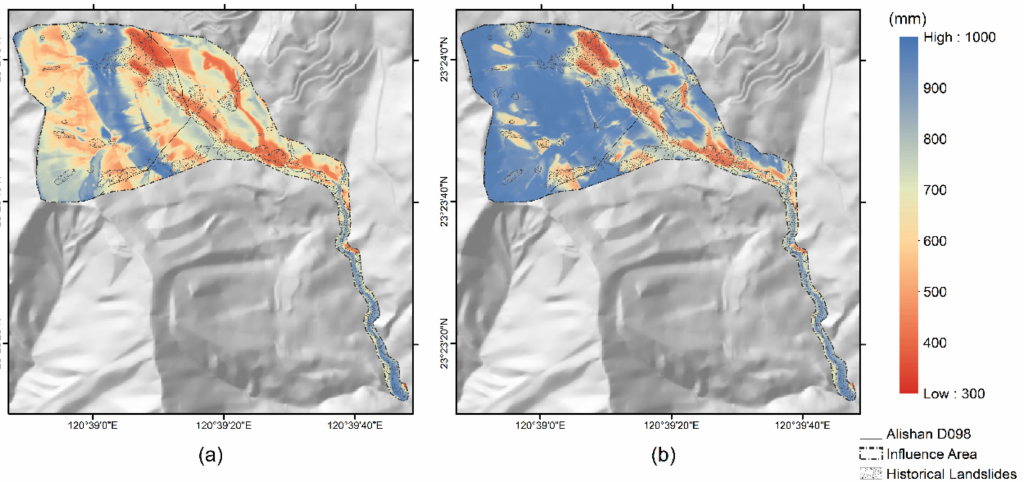
Figure 11. The spatial distribution of landslide rainfall threshold in Alishan D098 influence area. ( a ) Original result, which did not take the landslide susceptibility into account; ( b ) revised result, which did take the landslide susceptibility into account.